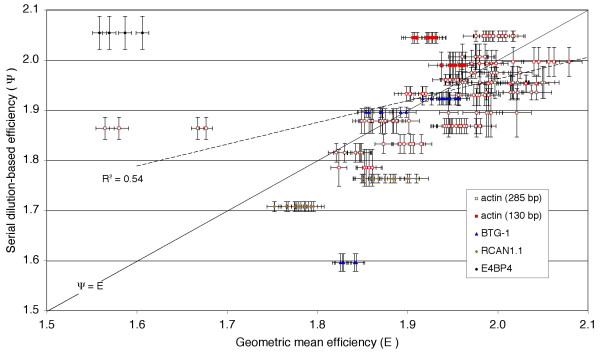
Geometric mean efficiency (E) is not revealed by serial dilution-based determinations of Ψ. Symbols indicate 219 individual samples, from 28 dilution experiments involving 5 different amplicons. Y-axis error bars are the standard deviations of Ψ (propagated from the slope variance of each experimental cq vs. log10A0 graph); x-axis error bars are standard deviations of E = (ACq/A0)1/Cq where ACq has a known a posteriori error of 8% (from variance in qPCR instrument calibration slopes), and A0 has an a priori error of 10% (from known precision of pipetting and dilution). Dashed diagonal line: Linear regression correlation of Ψ vs. E (R2 = 0.54). Solid diagonal line: Reference along which Ψ = E.